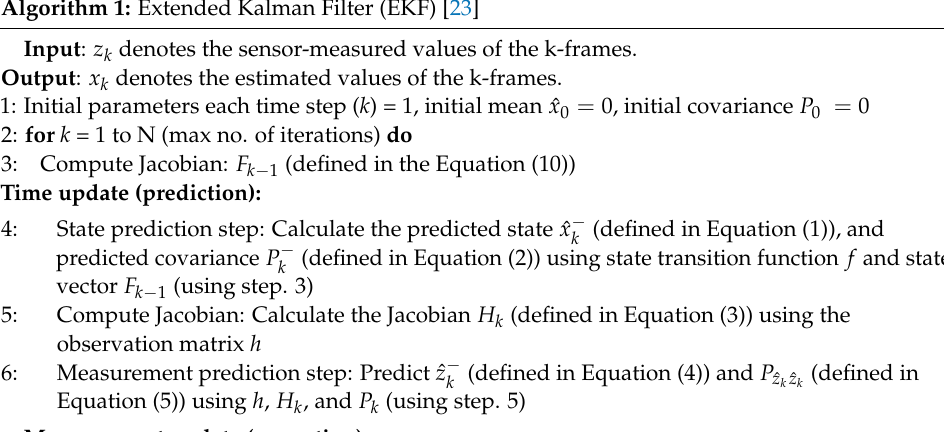
Algorithm 1: Extended Kalman Filter (EKF)